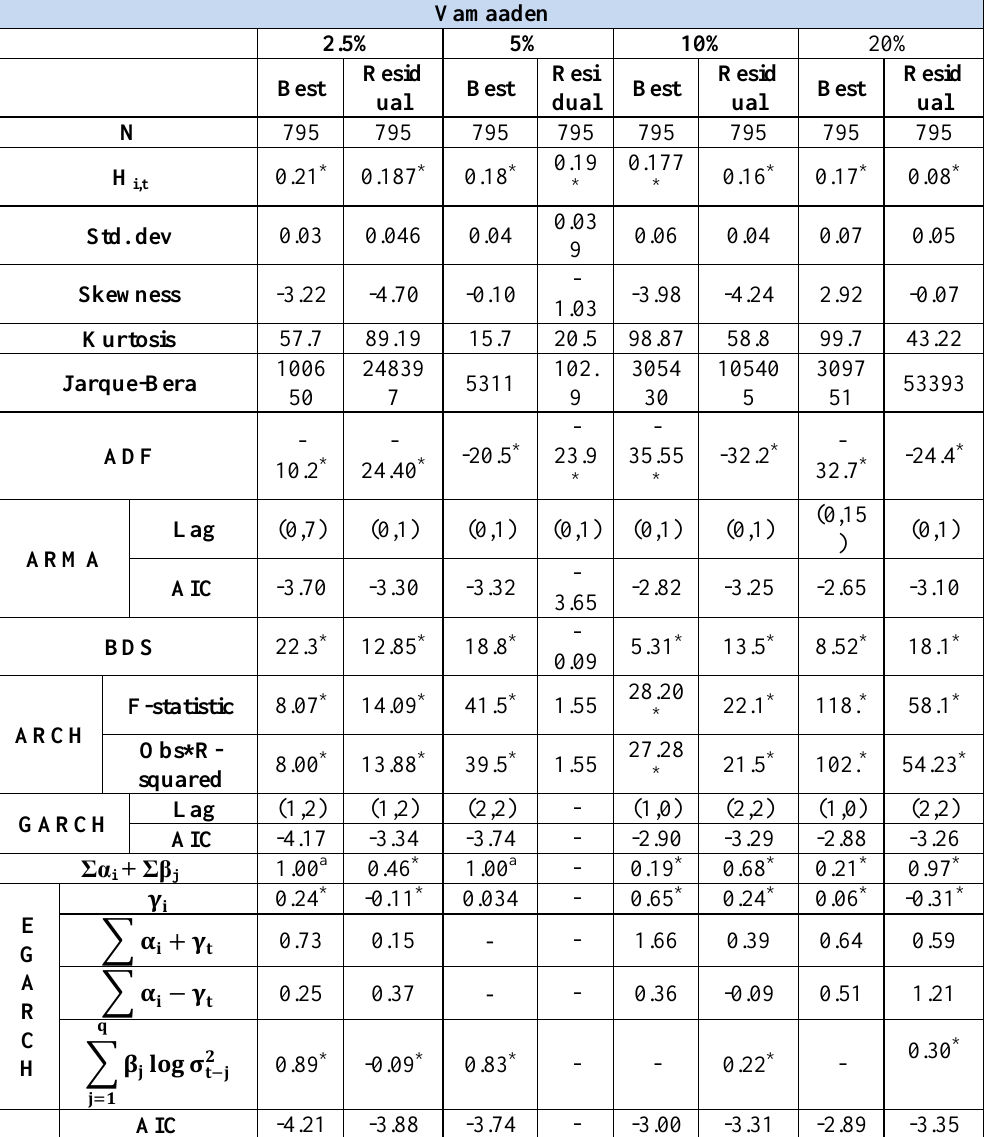
Table 5. Econometric statistics for the Vamaaden price series estimated